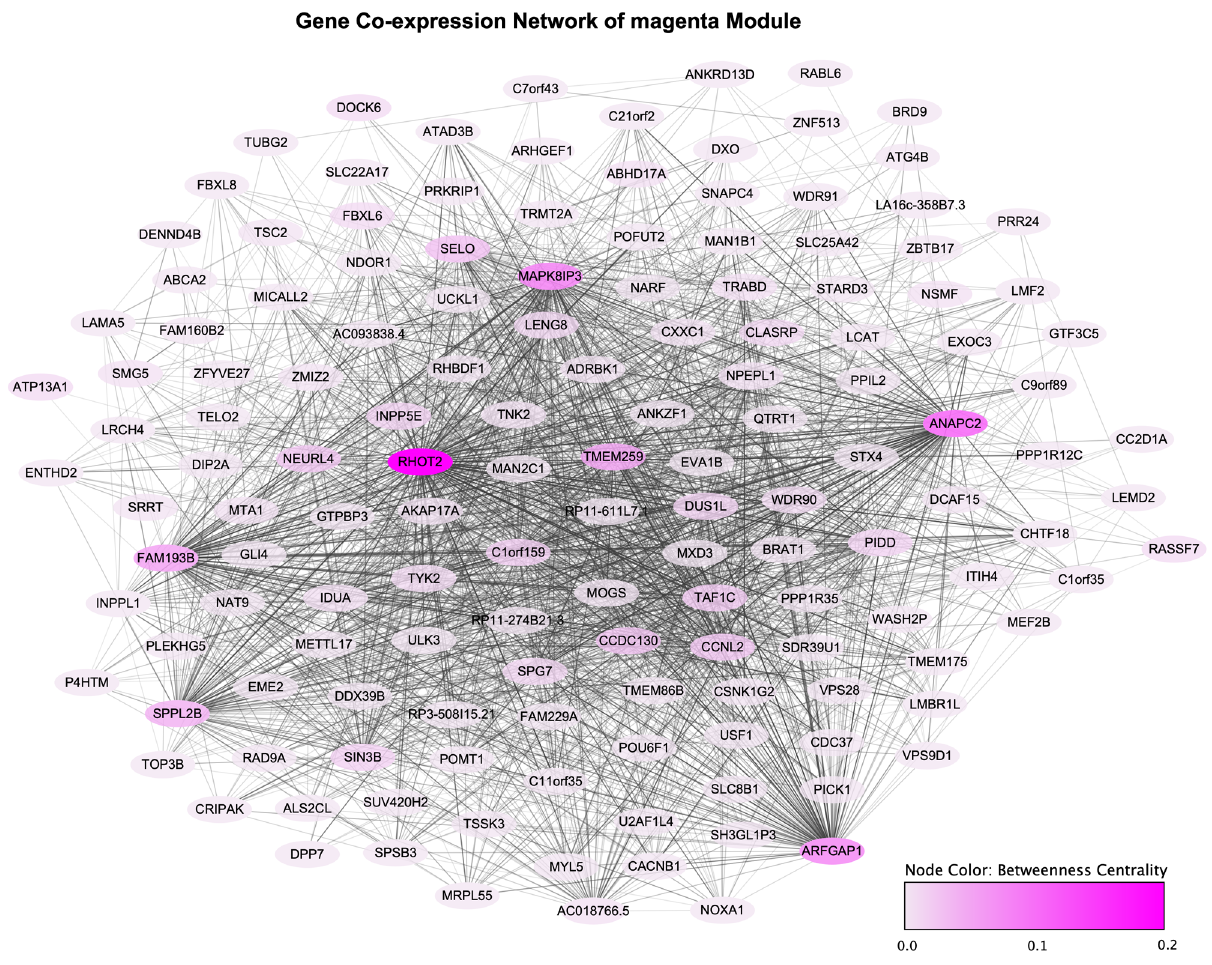
Figure 3. Gene co-expression network of magenta